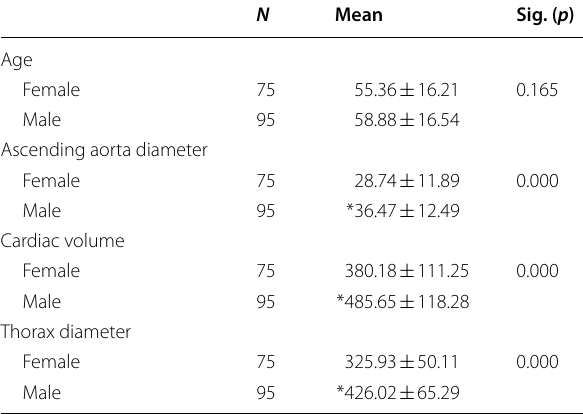
Table 3 Independent samples test morphologic and demographic variables by gender